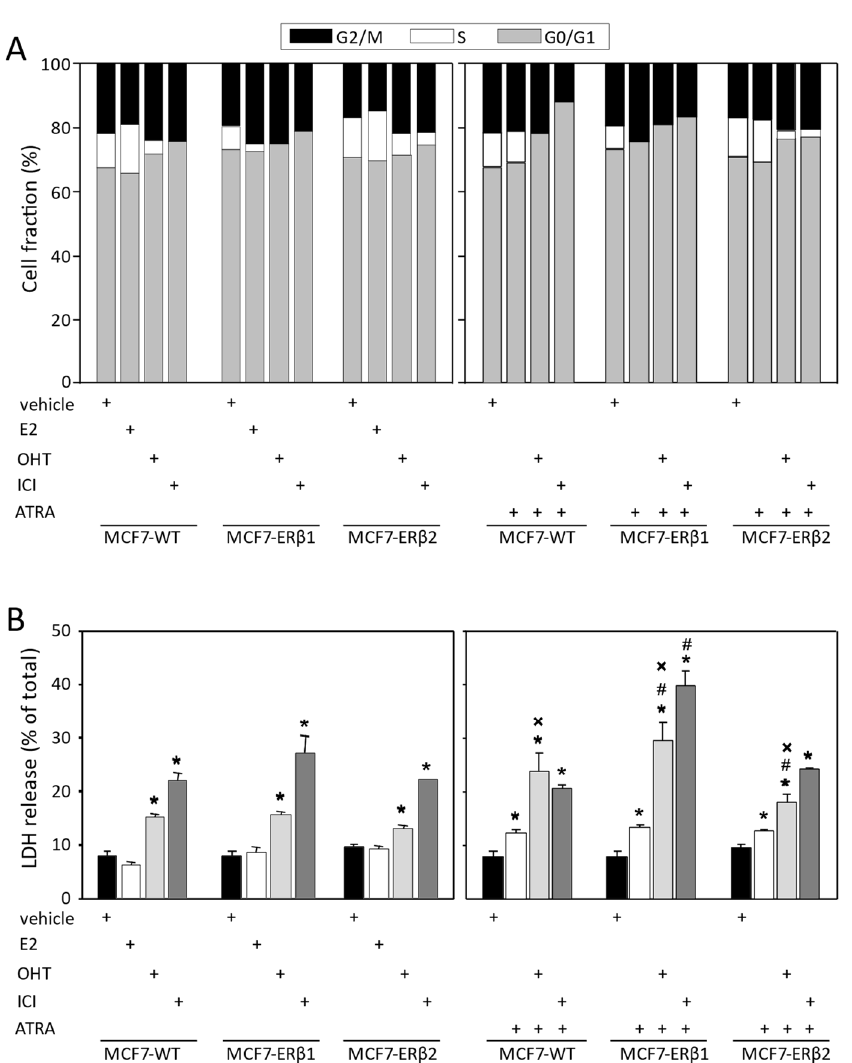
Figure 4. OHT, ICI and ATRA abolished the S-phase fraction and induced cell death in ER β 1-expressing cells. ( A ) Cell cycle phase distribution of MCF7-WT, MCF7-ER β 1 and MCF7-ER β 2 cells treated for 72 h with vehicle (0.1% DMSO), E2 (10 nM), OHT (100 nM), ICI (100 nM), ATRA (50 nM) or their indicated combination, as assessed by flow cytometry. Plots are representative of at least three independent experiments. ( B ) LDH release (relatively to total LDH) from MCF7-WT, MCF7-ER β 1 and MCF7-ER β 2 cells treated as in ( A ). Values are mean ± SEM of at least three independent experiments carried out in triplicate. * p < 0.05 vs. vehicle of the respective cell line, # p < 0.05 vs. similarly treated MCF7-WT cells, x p < 0.05 vs. single-agent treatment of the respective cell line. E2, 17 β -estradiol; OHT, 4-hydroxytamoxifen; ATRA, all-trans retinoic acid; ICI, ICI182,780; LDH, lactate dehydrogenase.